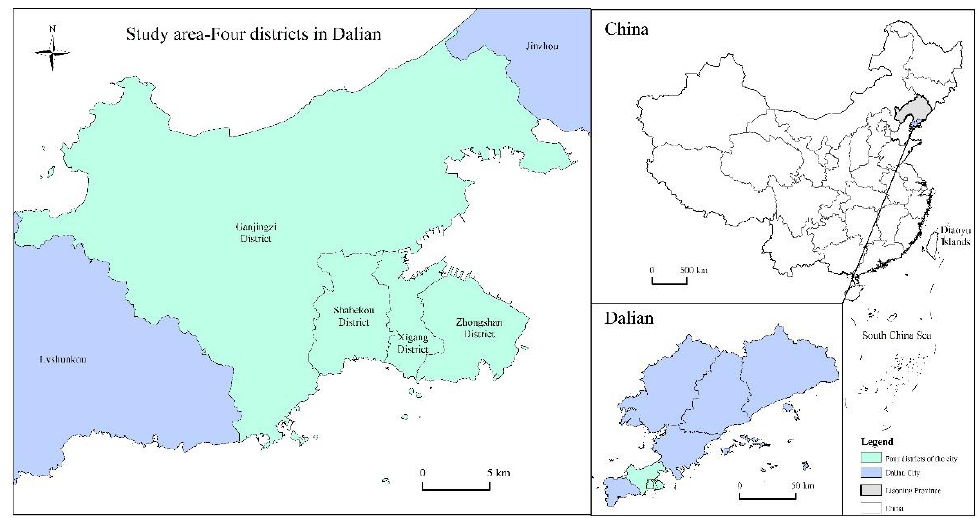
Figure 1. The location of study area.